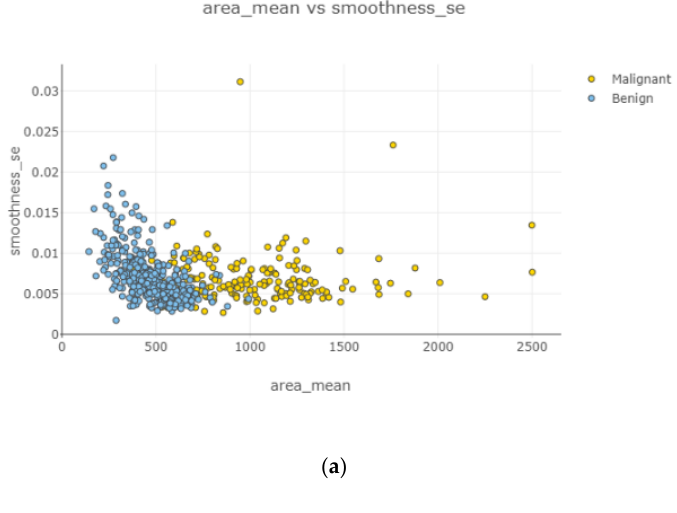
Figure 12. Negatively correlated scatter plots 1–4.